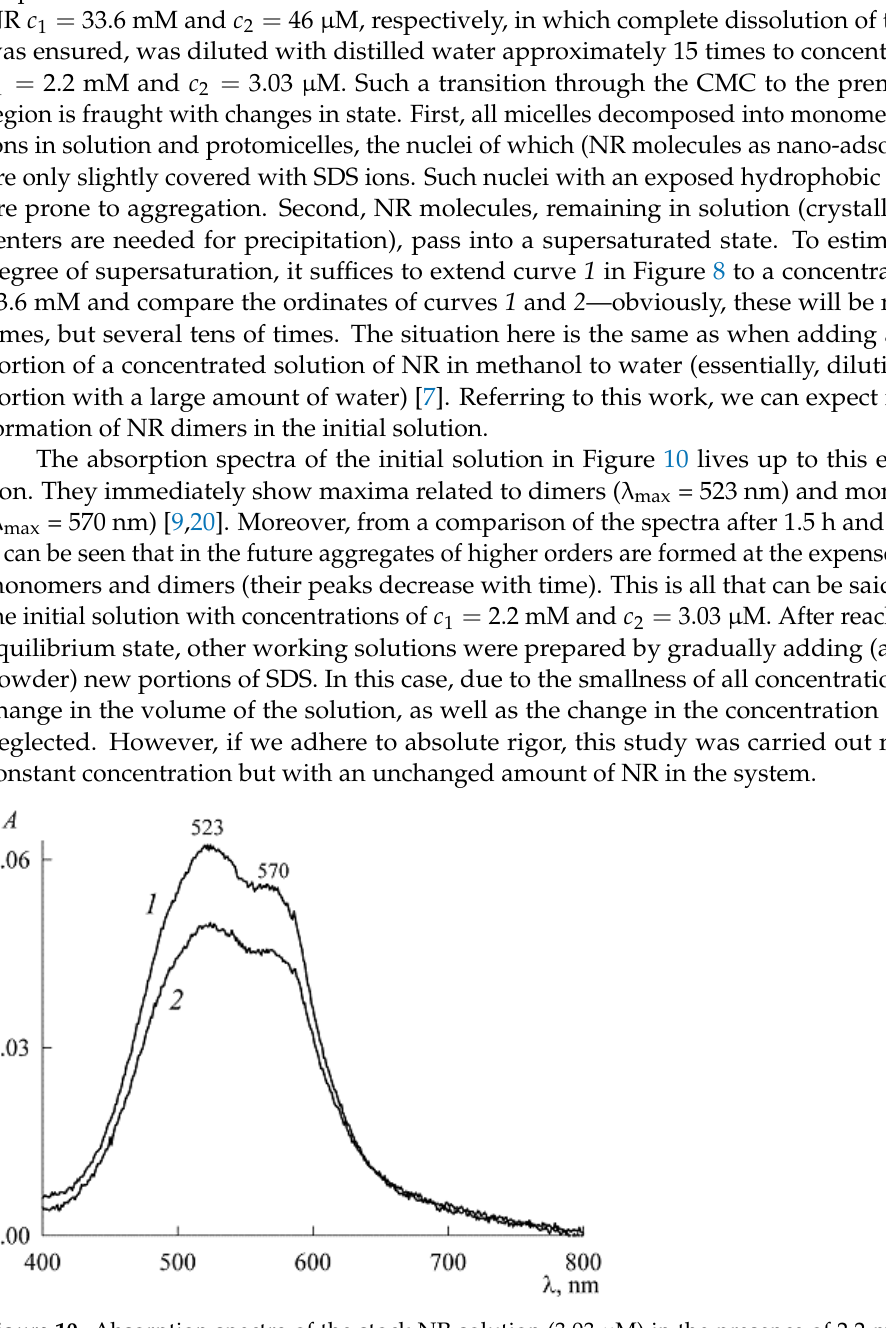
Figure 10. Absorption spectra of the stock NR solution (3.03 µ M) in the presence of 2.2 mM SDS, 1.5 h (curve 1 ) and 6 days (curve 2 ) after preparation.